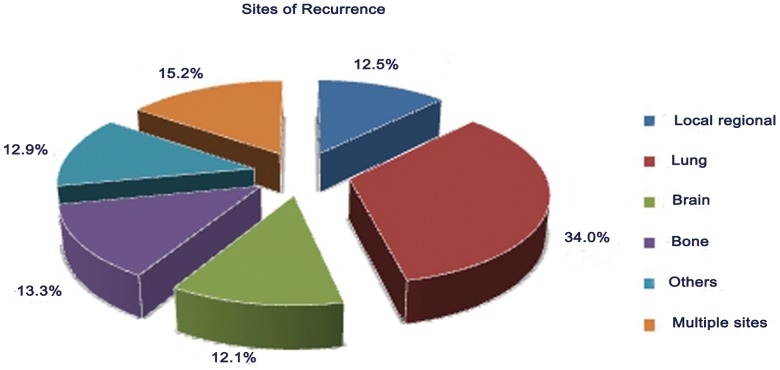
Relative frequencies for recurrence sites for postoperative early-stage NSCLC.